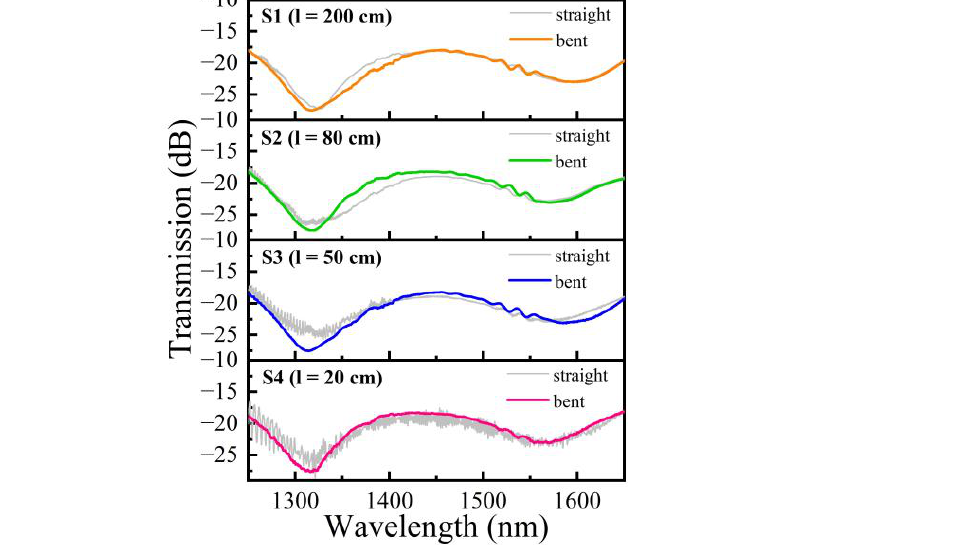
Figure 5. Transmission spectra of four fabricated cascaded MZI samples S1, S2, S3, and S4 with decreasing lengths of transmission SMF (i.e., SMF 2 ) between MZI 1 and MZI 2 of 200, 80, 50, and 20 cm, respectively, in the straight and bent state.